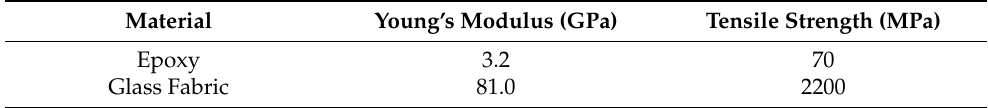
Table 5. Fibre and matrix mechanical